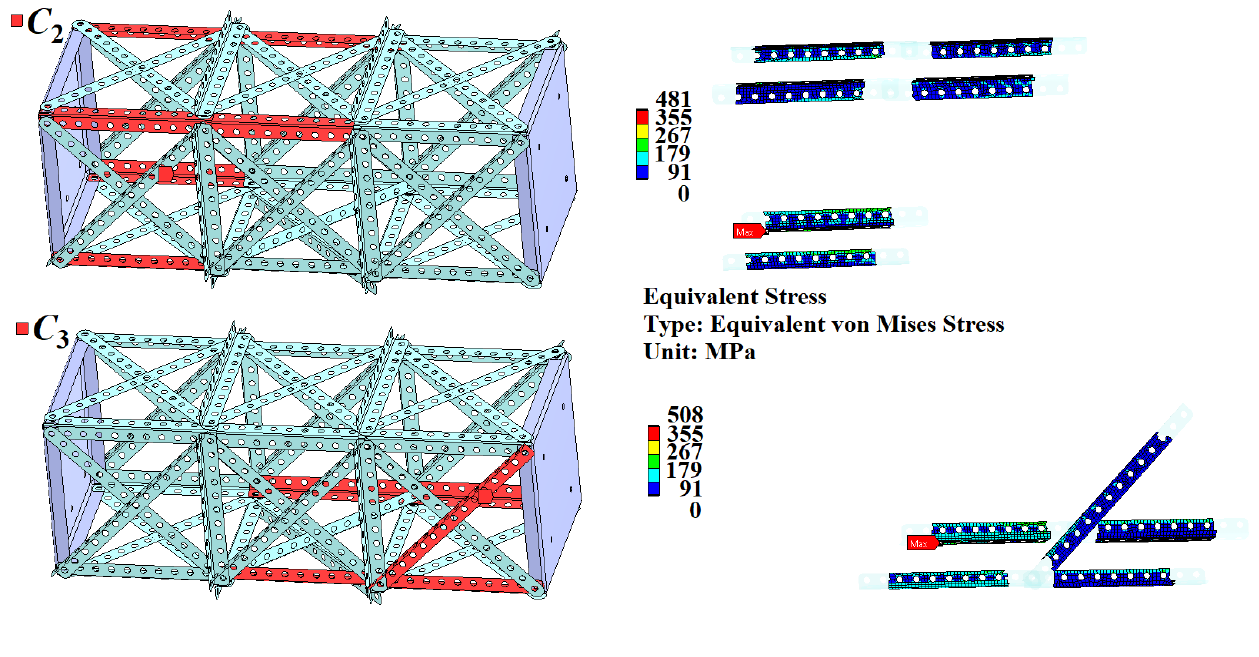
Figure 11. Results for Model 2, with components C 2 and C 3